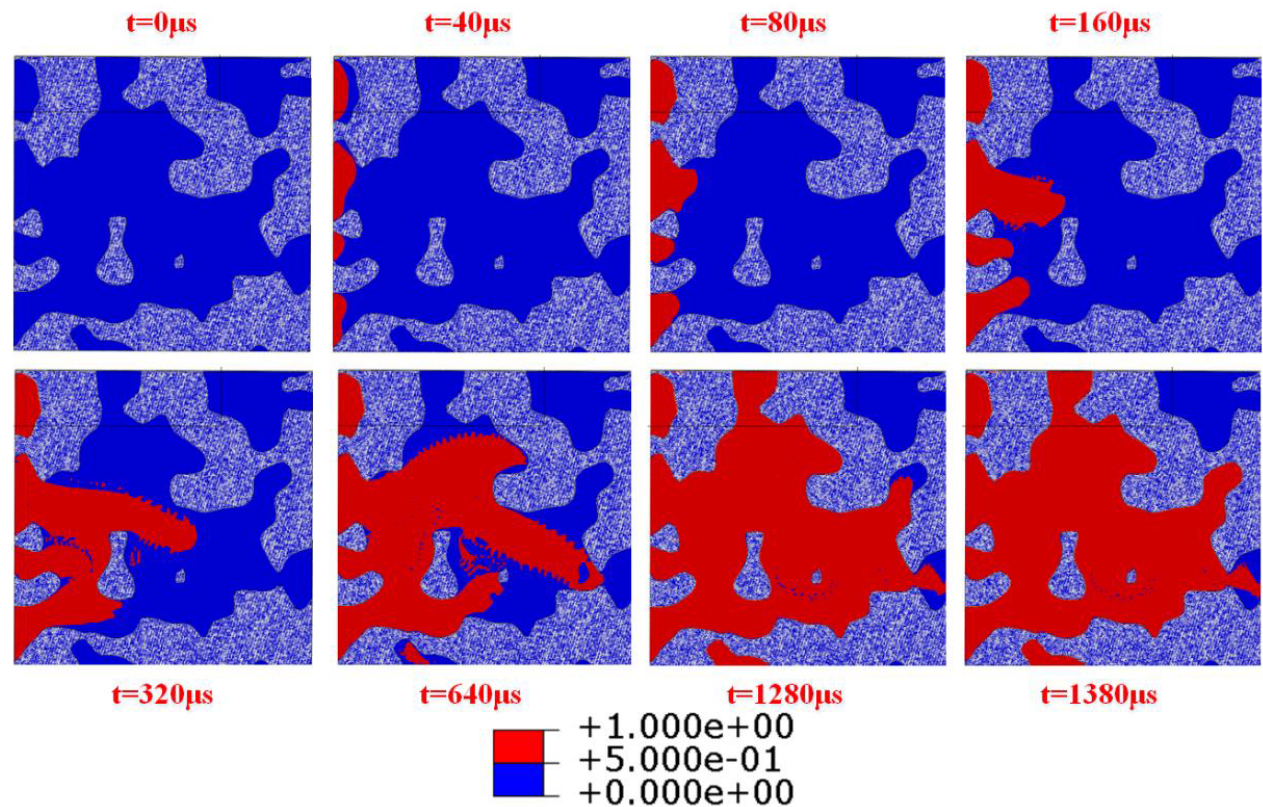
Figure 9. Distribution characteristics of medium on sealing surface.